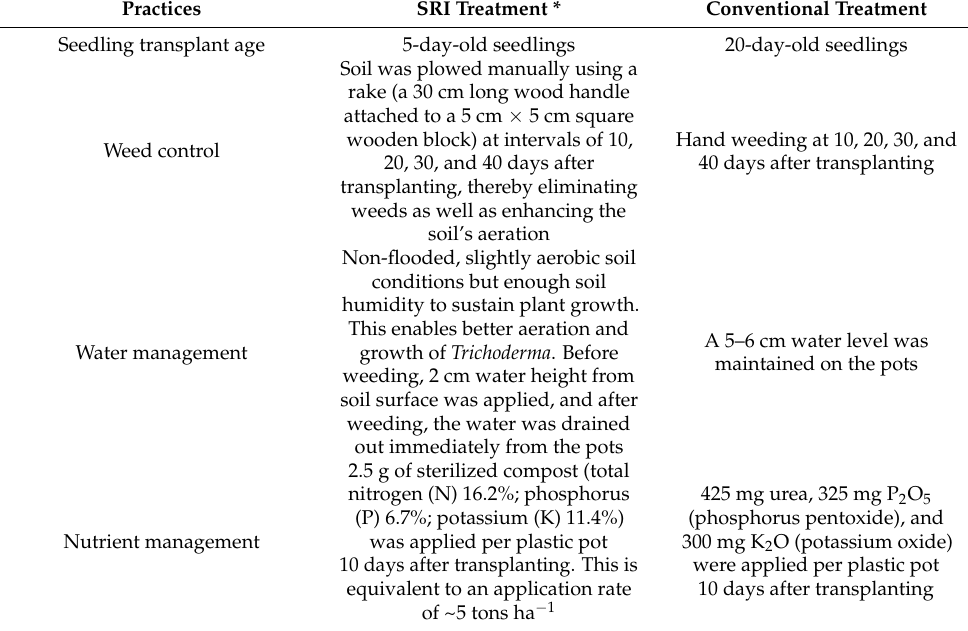
Table 2. Crop management in this study: SRI compared with conventional